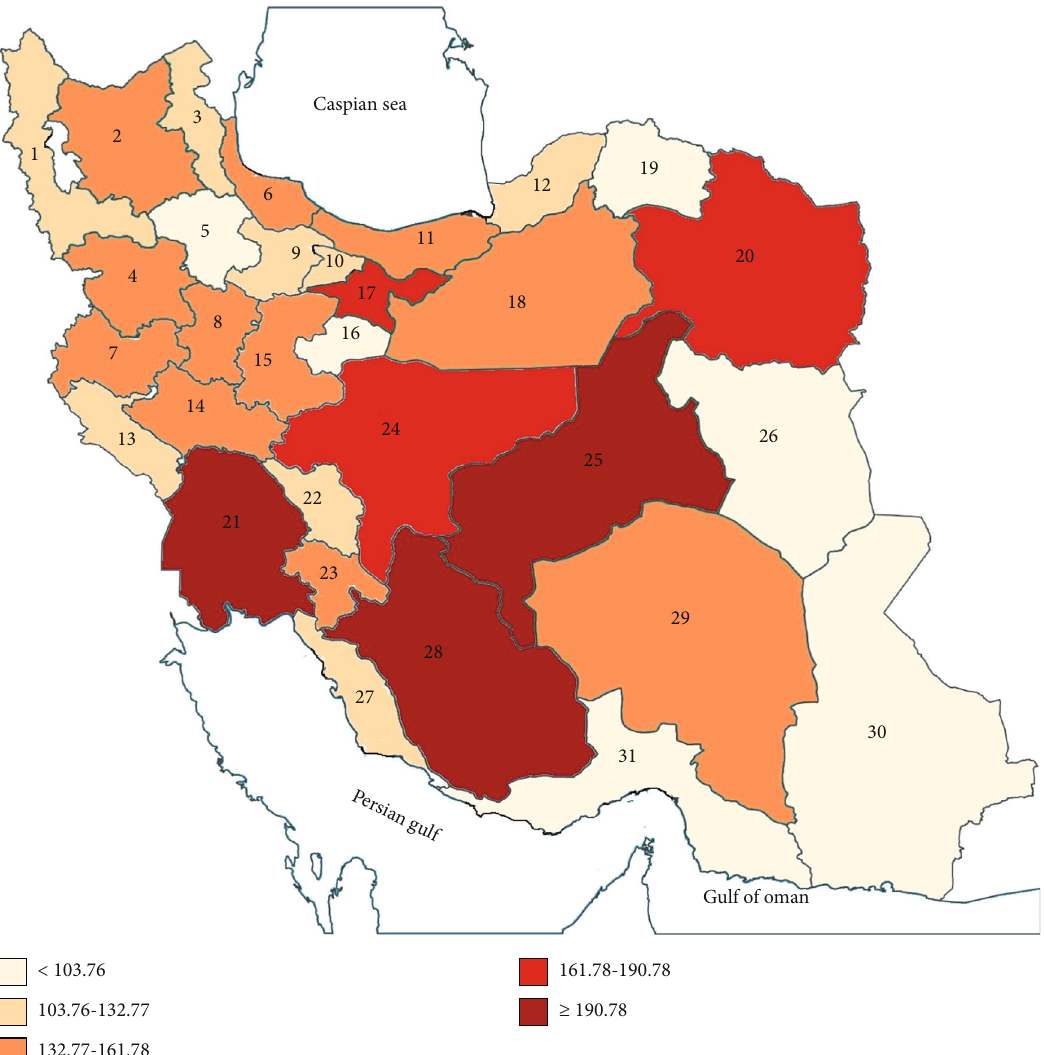
Figure 2: Cancer age-standardized rate (ASR) for both sexes in provinces of Iran in 2016. 1 indicates West Azarbayjan, 2: East Azarbayjan,